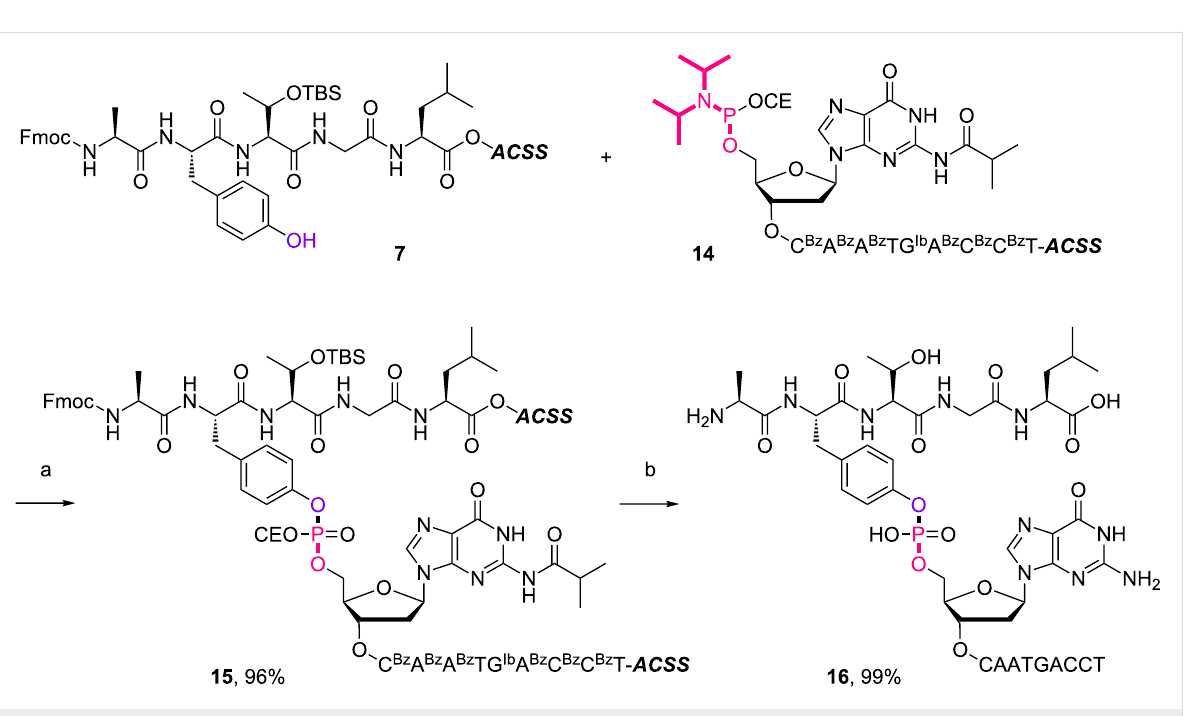
Scheme 4: Conjugation between 5’-activated supported decanucleotide 14 and supported pentapeptide 7 . Reagents and conditions: (a) (i) pentapep- tide (2.0 equiv), BMT (2.0 equiv), CH 2 Cl 2 /CH 3 CN/DMF (20:2:1, v/v/v), rt, 30 min; (ii) 0.67% BPO/DMP/CH 2 Cl 2 , rt, 30 min, 96% over 2 steps. (b) (i) 5% DCA/CH 2 Cl 2 , rt, 5 min; (ii) NH 3 aq/EtOH (3:1, v/v), 70 °C, 3 h; (iii) TEA 3HF/DMF, rt, 24 h, 99% over 3